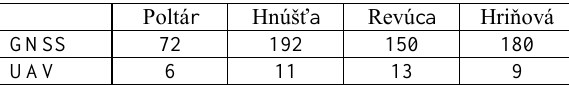
Table 4. Data collection time for GNSS and